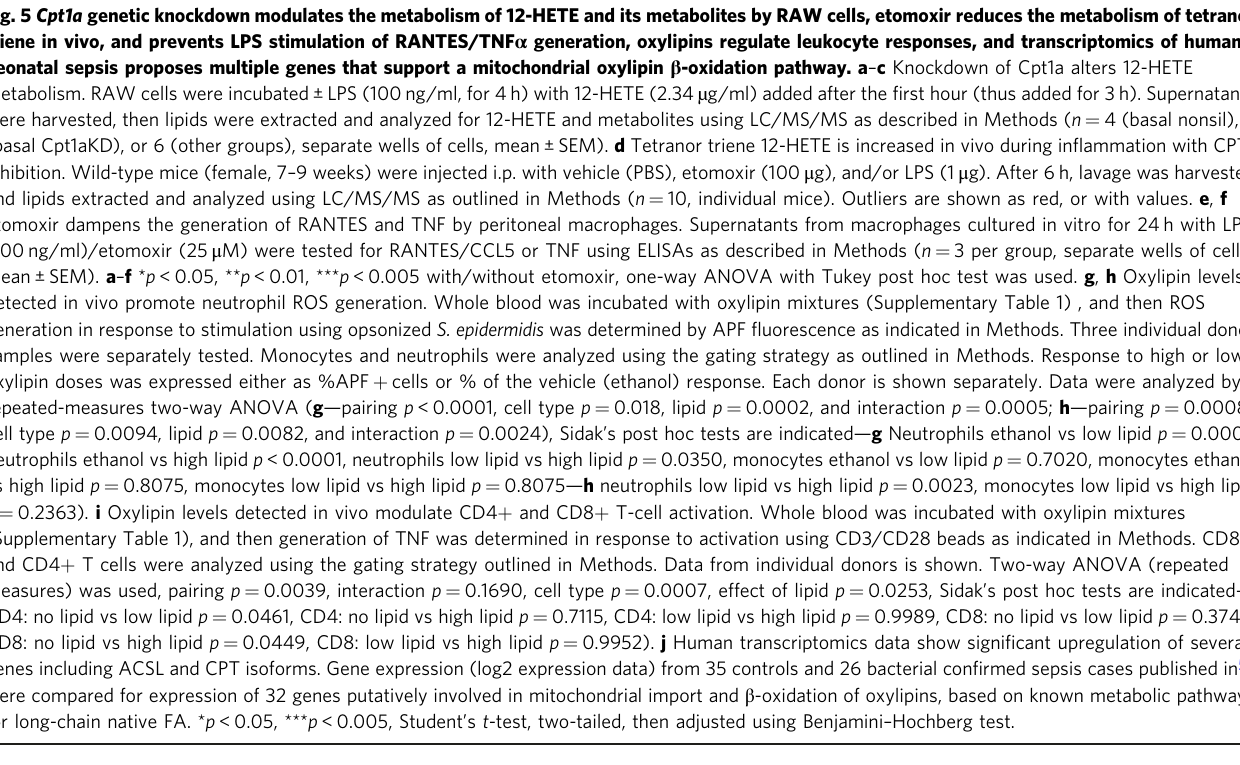
Fig. 5 Cpt1a genetic knockdown modulates the metabolism of 12-HETE and its metabolites by RAW cells, etomoxir reduces the metabolism of